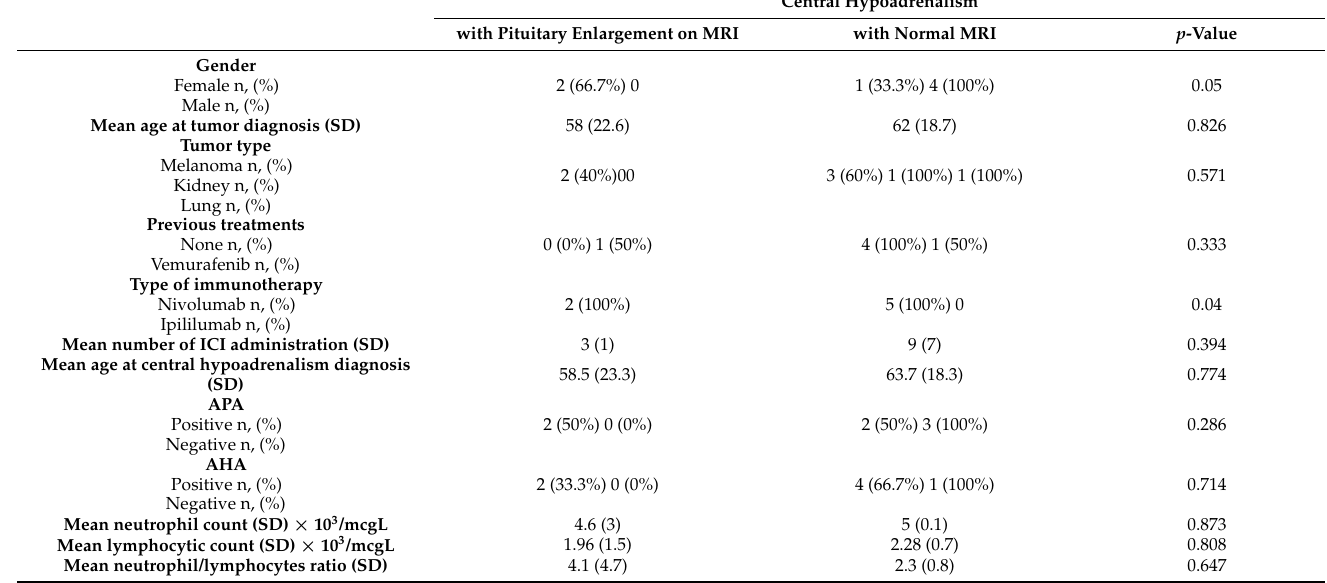
Table 2. Comparative analysis of demographic and clinical features of patients with ICI-induced central hypoadrenalism with and without the typical radiological signs of hypophysitis. Descriptive statistical analyses included finding the mean and standard deviation (SD) for continuous variables and absolute and relative frequencies for qualitative variables. Chi-squared and T-student tests were applied for univariate analysis. N: